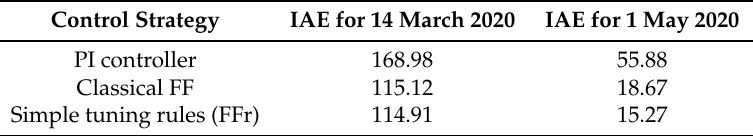
Table 2. Integral Absolute Error (IAE)